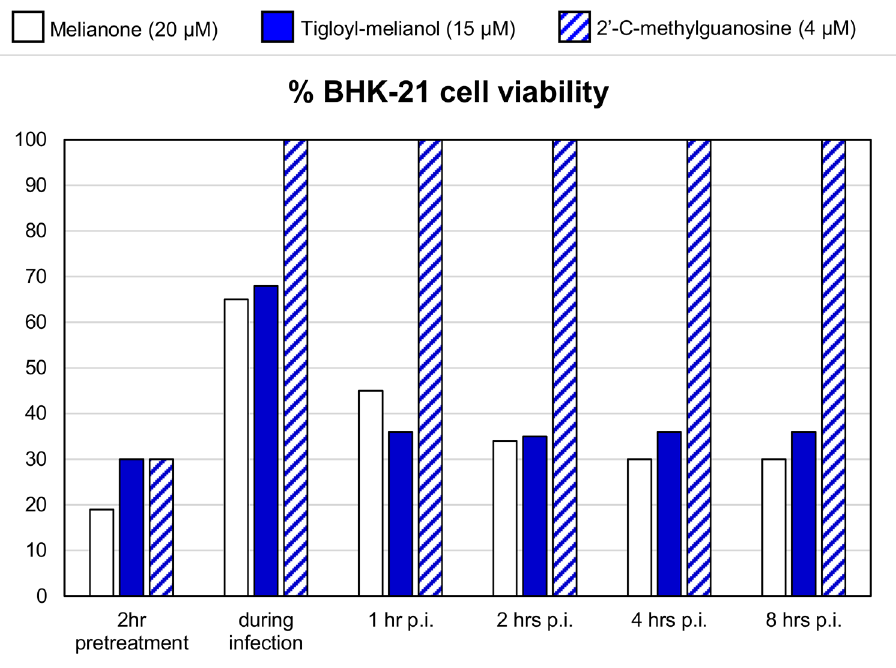
Fig 3. Time of drug addition. Melianone, 3- α -tigloyl-melianol and a reference compound were added during the infection and at different times post infection (p.i.). Each value represents a mean of duplicate assays. When added 1 hour or more p.i. the two compounds are not more able to protect BHK-21 cells, differently to reference compound. % of cell viability is reported; value for the untreated infected control is 15%.